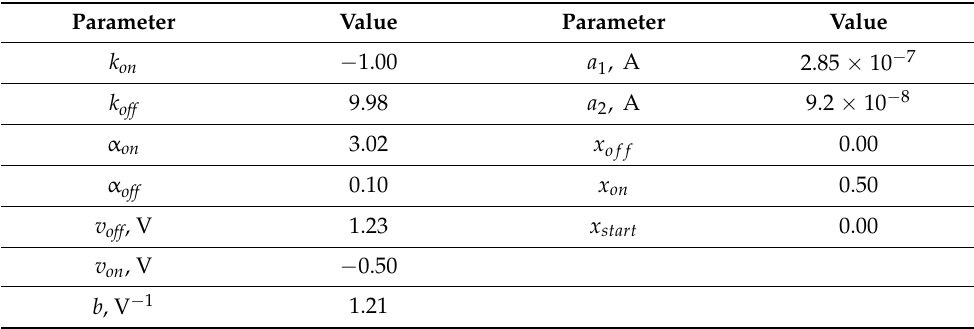
Table 5. Optimal values of VTEAM model parameters with rectangular window function, obtained by approximating the experimental contour.